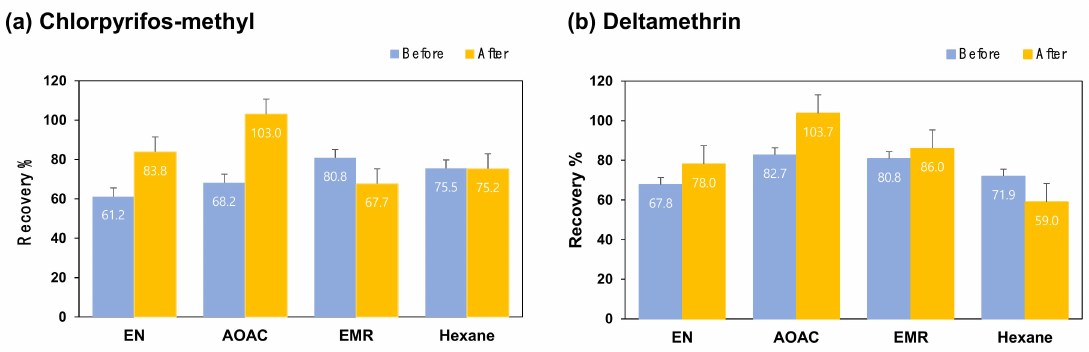
Figure 3. Recoveries of ( a ) chlorpyrifos–methyl and ( b ) deltamethrin obtained from four di ff erent clean-up methods before and after cooling extracts at − 20 ◦ C for 24 h. EN—150 mg MgSO 4 + 25 mg PSA + 25 mg C18; AOAC—150 mg MgSO + 50 mg PSA + 50 mg C18; EMR-lipid TM and 10 mL n 4